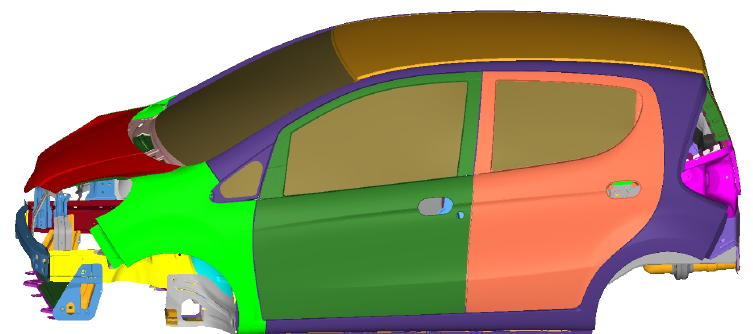
Figure 1. Vehicle body finite element